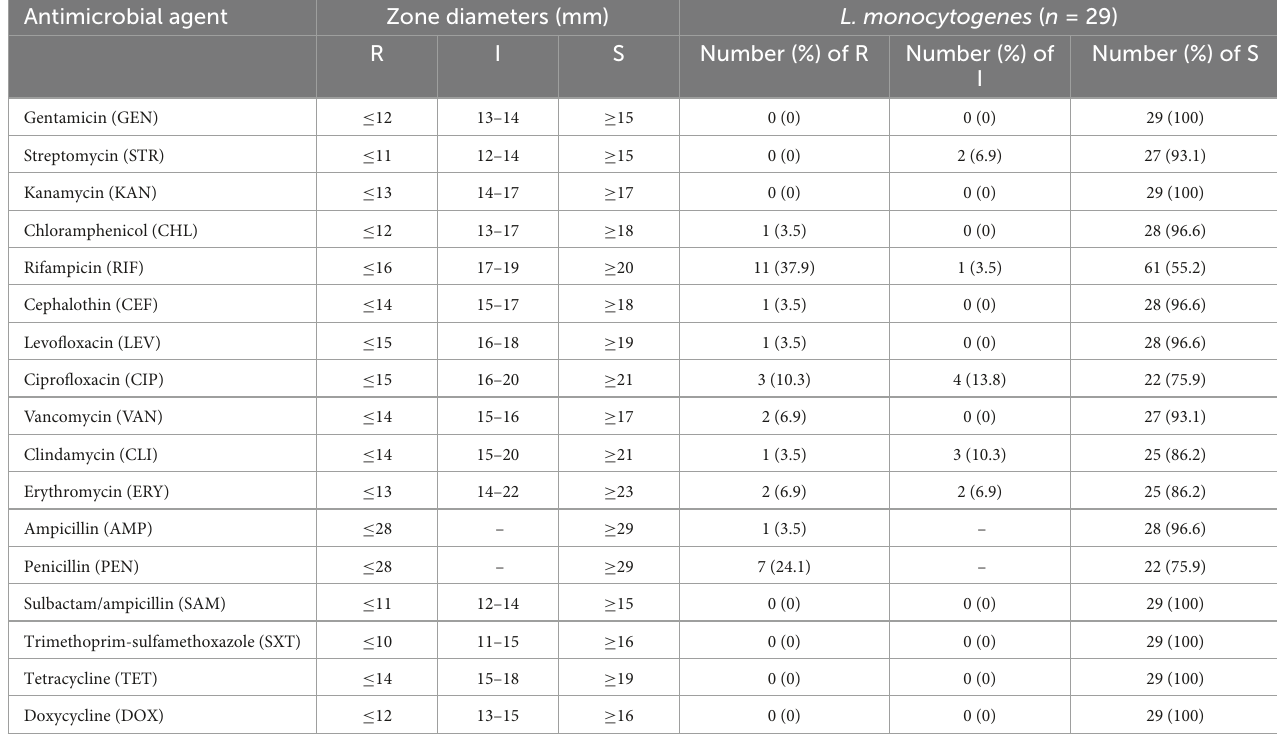
TABLE 2 Results of antimicrobial susceptibility tests of Listeria monocytogenes isolates obtained from Pleurotus eryngii production plants. Antimicrobial